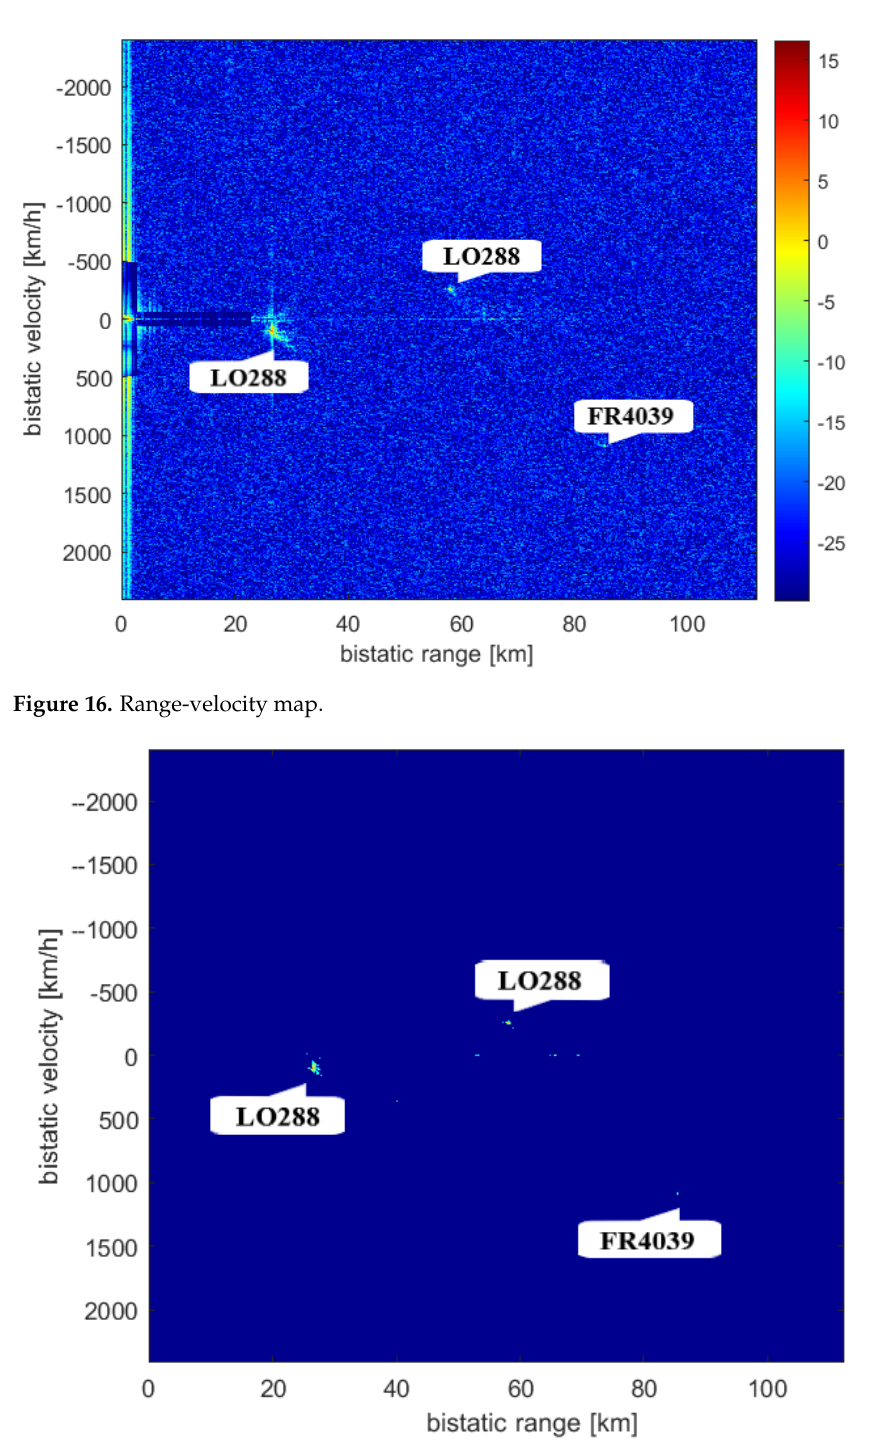
Figure 17. Range-velocity map after